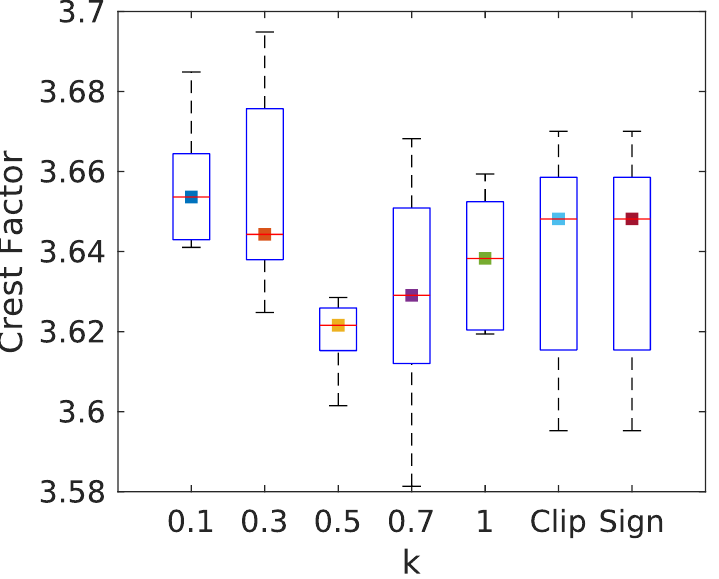
Figure 5. Boxplot of the final crest factor output as a function of the transformation functions, including the sigmoid function (k = 0.1, 0.3, 0.5, 0.7, 1), the clip function, and the sign